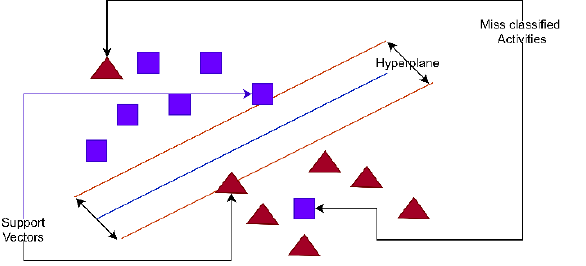
Figure 1. Typical Methodology of Support Vector